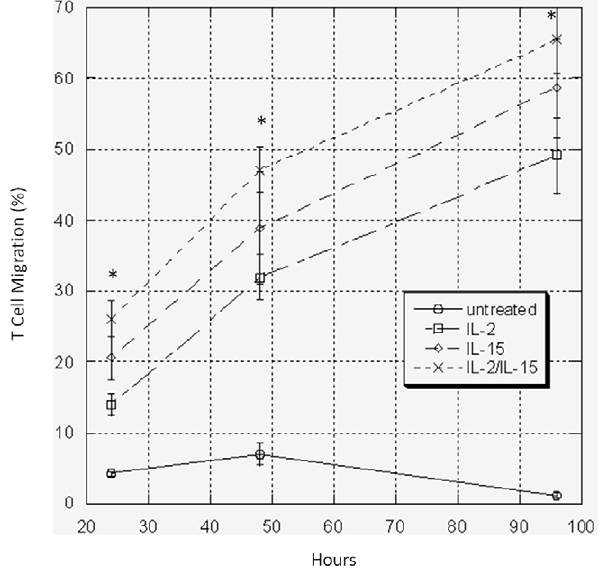
Figure 4. Effects of IL-2 and IL-15 on CTL migration. IL-2 (500 u/ ml), IL-15 (100 ng/ml), or the combination of IL-2/IL-15 was added into the fibrin clots (Formulation 1). ATP assays were performed to quantify the number of T cells that had migrated out of the clots after 24, 48, and 96 hours. T cell migration significantly increased out of treated clots containing IL-2, IL-15, or both compared to untreated clots. The data represents the means 6 SD of three independent experiments (* p , 0.01 IL-2, IL-15, or IL-2/IL-15 vs. untreated).